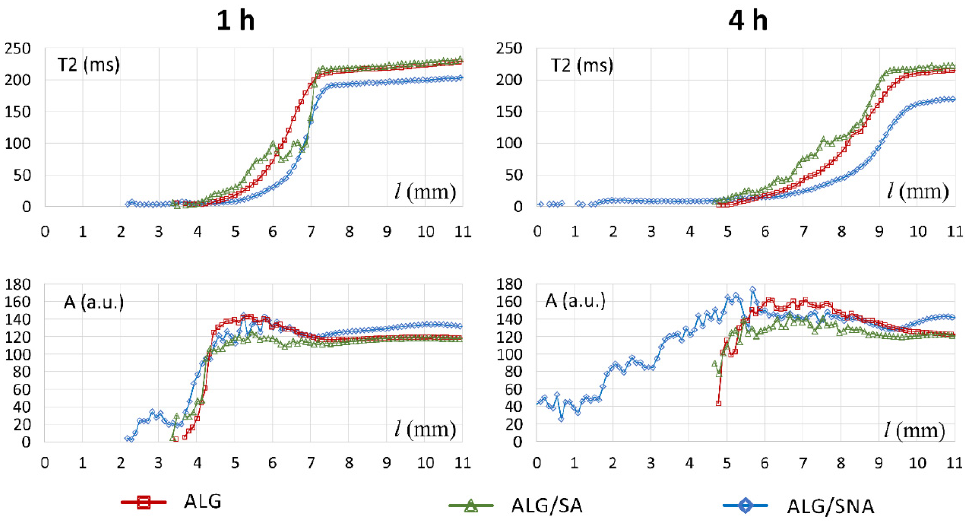
Figure 8. Comparison of T 2 /A profiles for three different matrices: ALG, ALG/SA, ALG/SNA at two hydration times of 1 and 4 h.